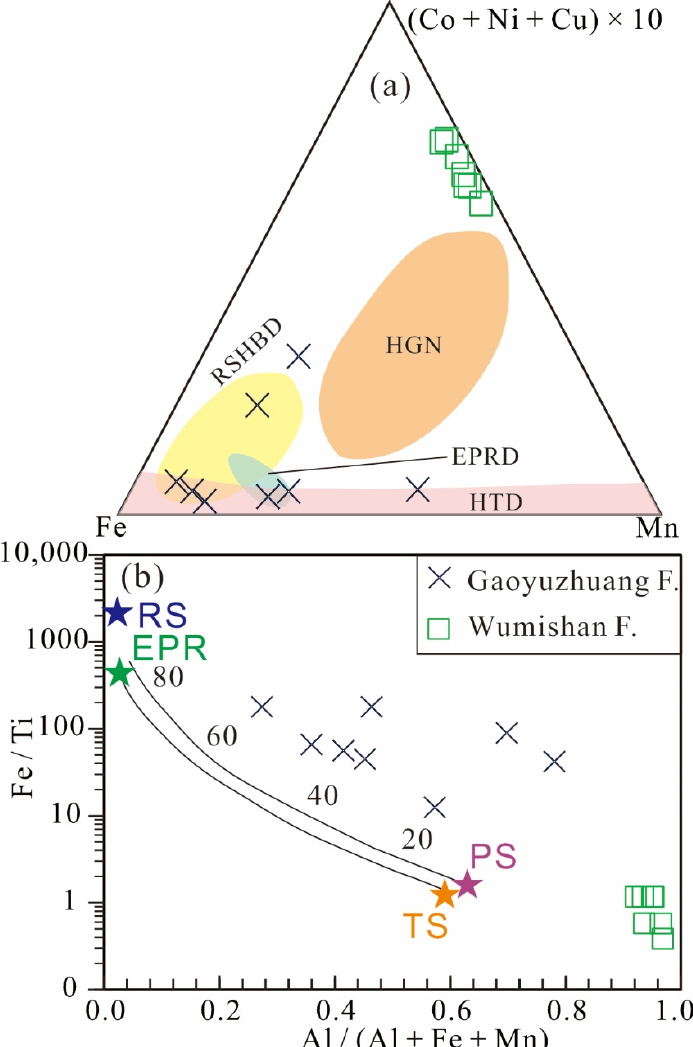
Figure 11. Plots of ( a ) (Co + Ni + Cu) × 10 – Fe − Mn and ( b ) Fe/Ti versus Al/(Al + Fe + Mn) for the carbonate rocks from the Gaoyuzhuang and Wumishan Formations. Abbreviations: RSHBD = Red Sea hot brine deposits, HGN = hydrogenous nodules, HTD = hydrothermal deposits, EPRD = East Pacific Rise deposits, EPR = East Pacific Rise, RS = Red Sea, TS = terrigenous sediments, PS = pelagic sediments.